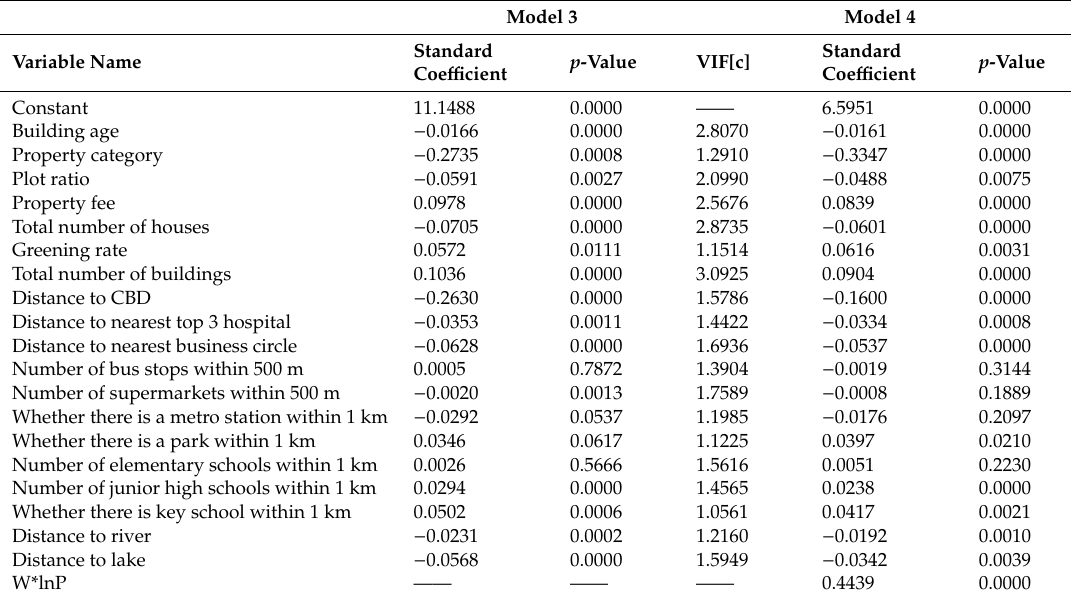
Table 6. Regression results of Models 3 and